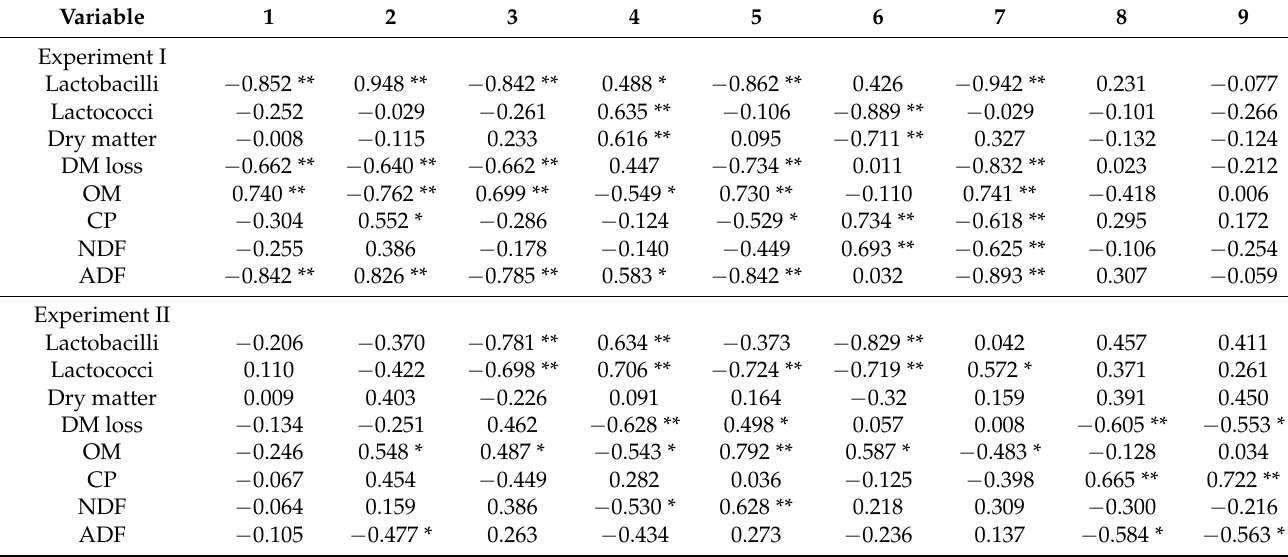
Table 13. Pearson’s correlations of the variablefor experiments I,